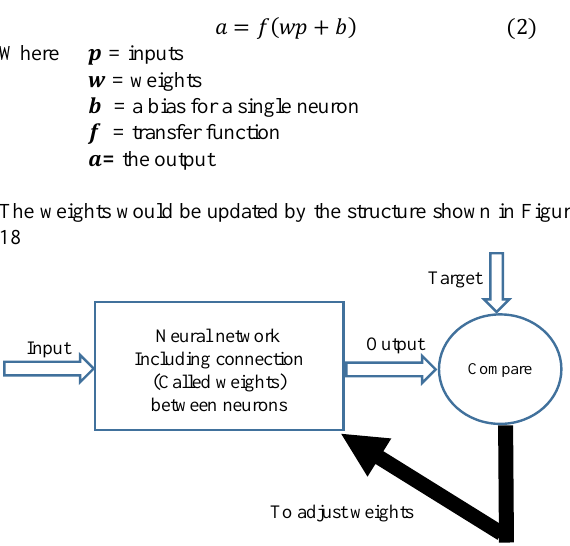
Figure 18. The MLP network structure